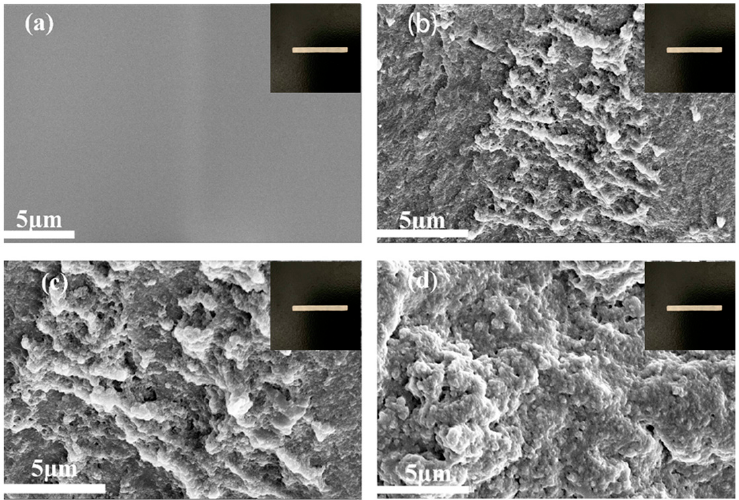
Figure 2. FESEM images of silica aerogel/resin composites before and after adding silica aerogel filler: ( a ) SA/R-0, ( b ) SA/R-5, ( c ) SA/R-6, ( d ) SA/R-2.